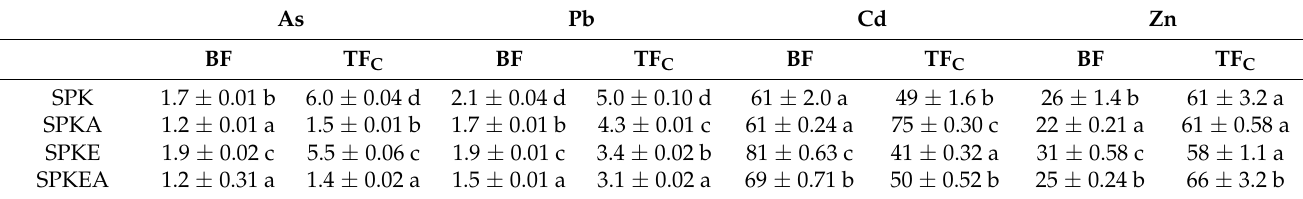
Table 6. Bioaccumulation factor (BF) and translocation factor which is estimated on the basis of concentration (TFc) of K. pentacarpos seedlings grown in polluted soil in the presence or absence of NaCl or/and EDDS for five months. Each value is the mean of 3 replicates and vertical bars are S.E. Values exhibiting different letters are significantly different at p < 0.05 according to SNK